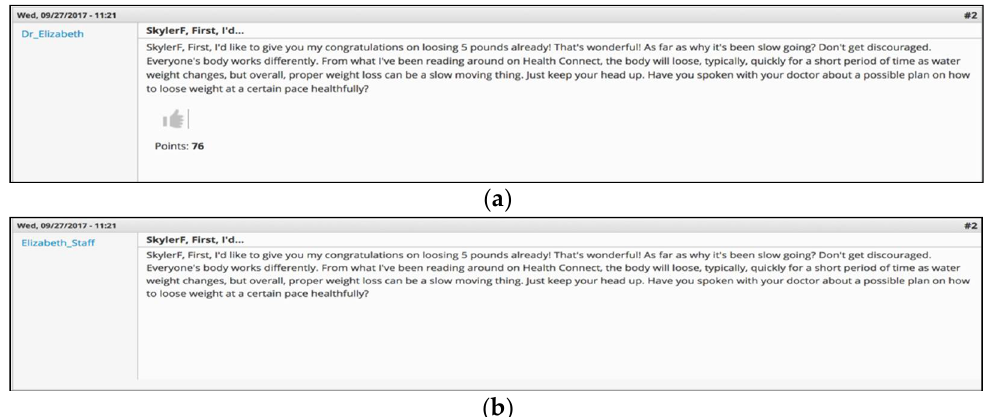
Figure 2. ( a ) Health Connect post with PDAs; ( b ) Health Connect with no PDAs.